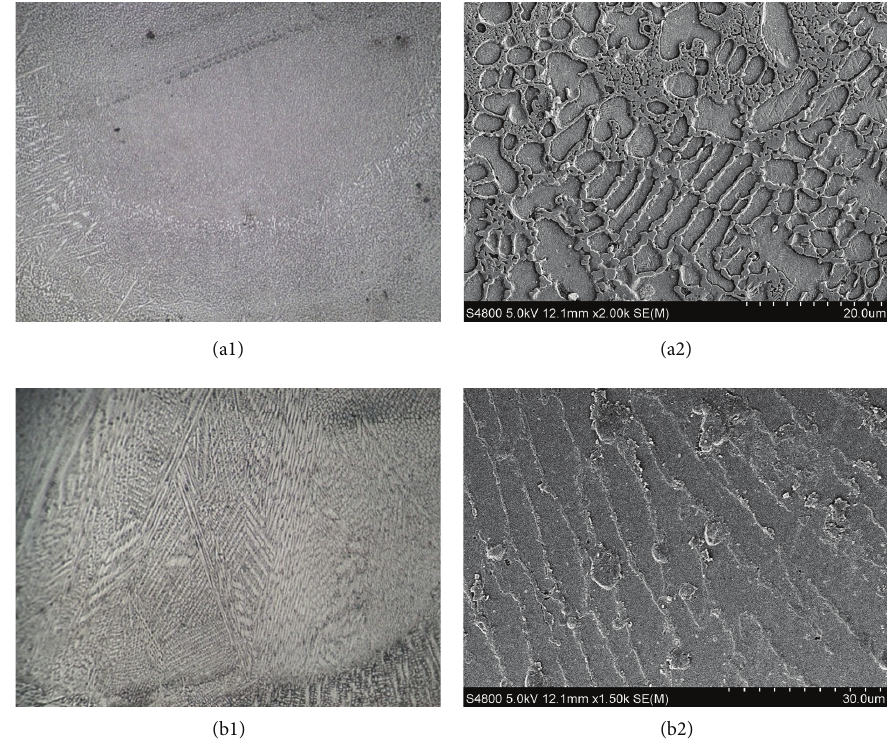
Figure 6: Morphologies of RZ: (a1) Fe314: OM × 100, (a2) Fe314: SEM × 1500, (b1) 316L: OM × 100, and (b2) 316L: SEM ×